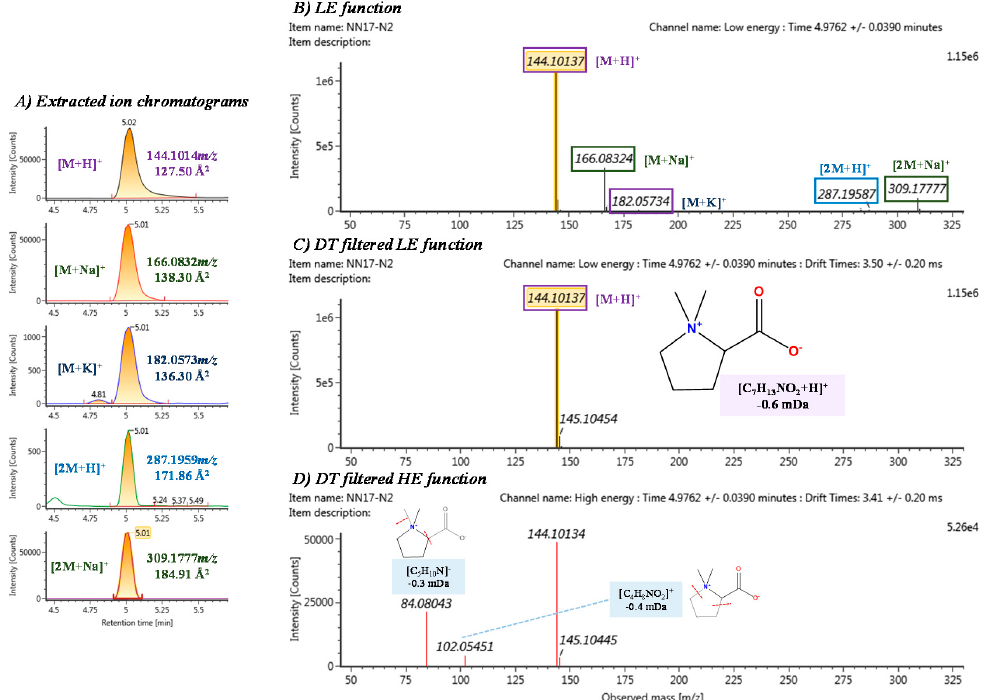
Figure 7. Elucidation of marker 6 based on chromatograms and HDMS E data obtained from HILIC pos analysis: ( A ) extracted ion chromatograms of all adduct and dimers found, along with the experimental m / z and CCS, ( B ) LE function, ( C ) DT filtered LE function and ( D ) DT filtered HE function. A proposed structure and fragmentation are shown.